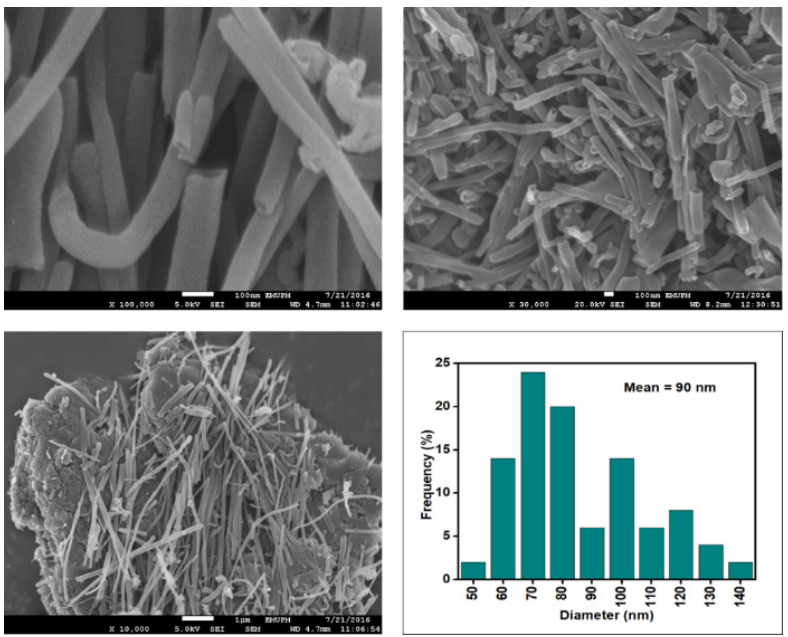
Figure 7. FESEM images of the CNF ‐ MA at 100, 30, and 10 resolutions and their corresponding diameter distribution histogram (mean diameter = 90 nm).